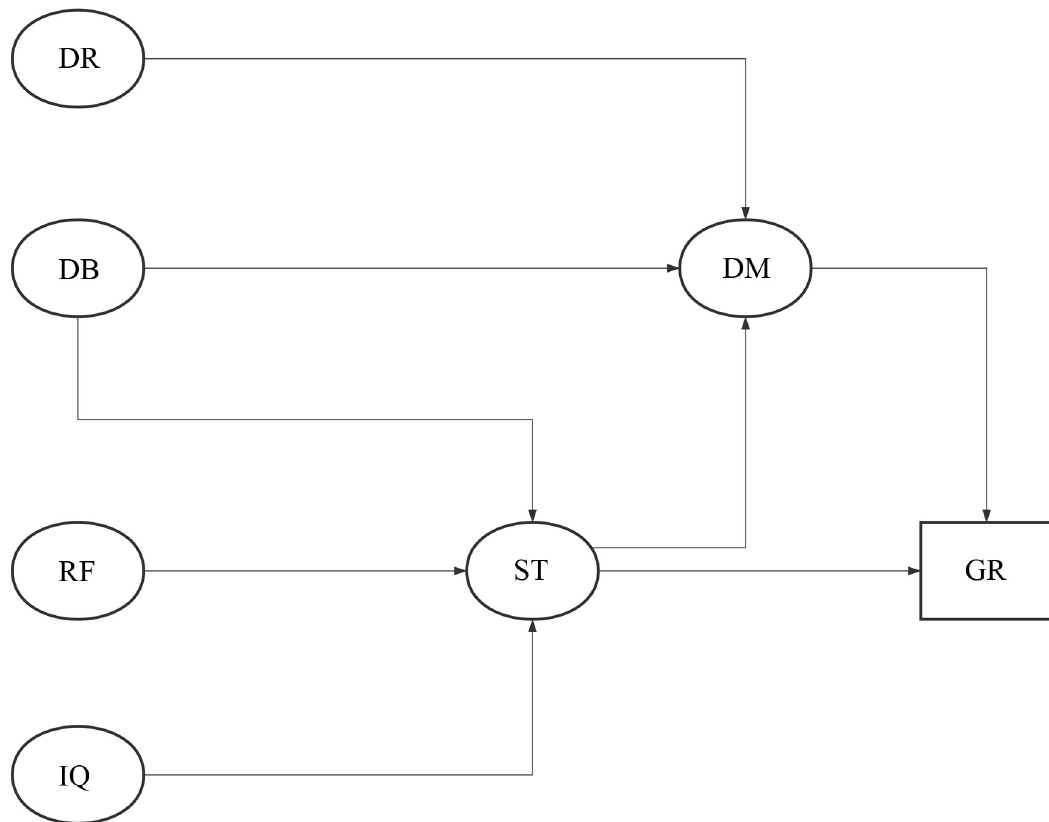
Fig 1. Theoretical research